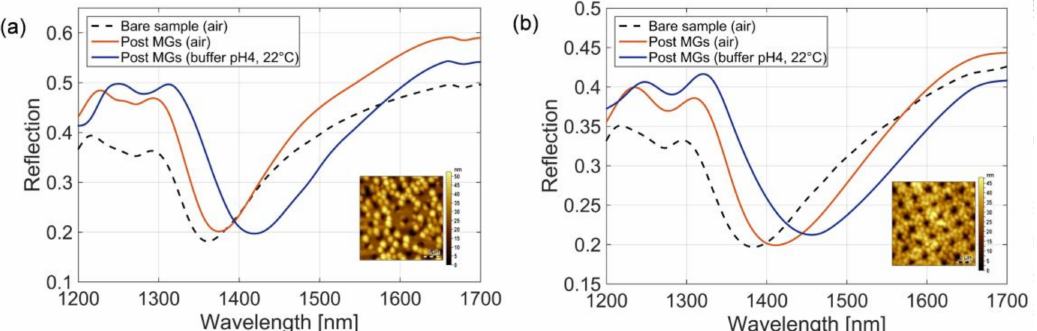
Figure 6. Experimental spectra evaluated before MGs deposition in air, and post MGs deposition, both in air, and buffer solution (pH 4, 22 ◦ C), of the sample 1, with coverage factor of 21% ( a ) and sample 2, with coverage factor of 92% ( b ). Insets in ( a , b ) show the MGs attached on the patterned optical fiber tip obtained by means of AFM